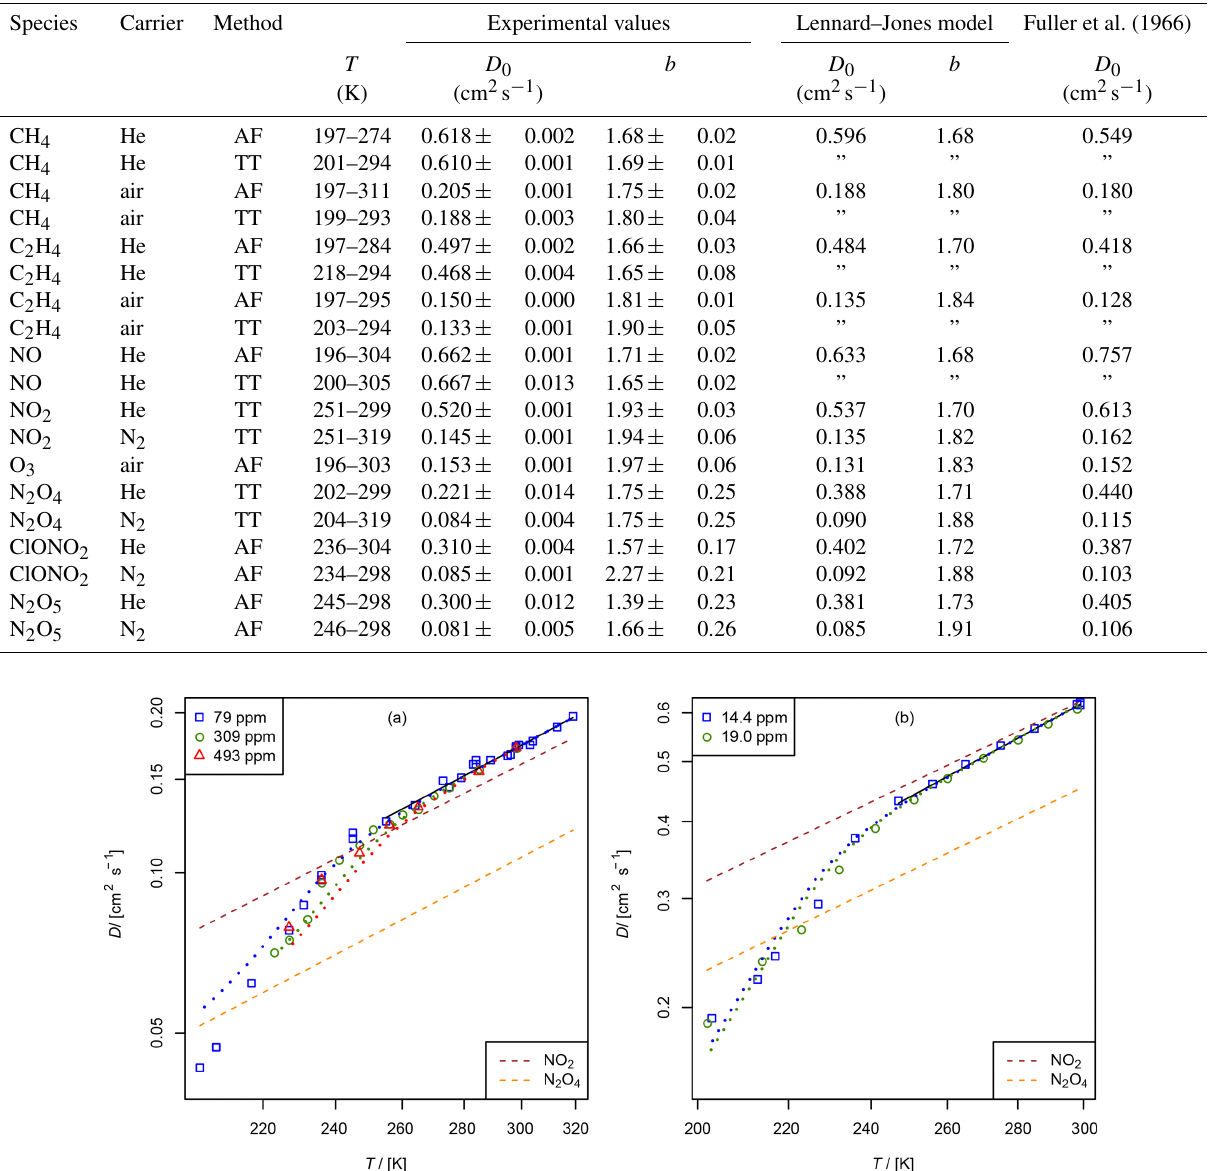
Figure 10. Apparent diffusion coefficient D( N IV ) of NO 2 / N 2 O 4 in N 2 (a) and He (b) as a function of temperature. Black solid line: fit of Eq. (5) to data points with α > 0 . 95. The dashed lines are calculated using the Lennard–Jones model. The dotted curves are fit curves of Eq. (23) by setting b( N 2 O 4 ) = 1 . 75.